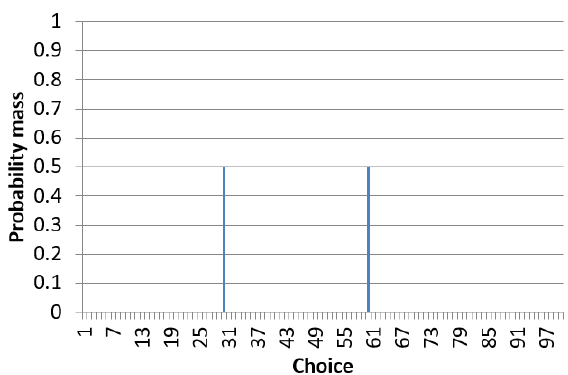
Figure 1. Example distribution for which compressing with k = 2 produces lower error than k = 3.